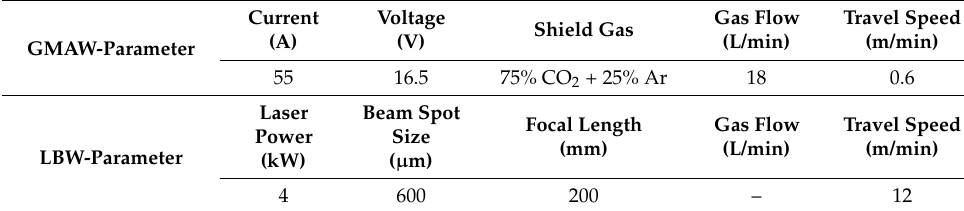
Table 2. Selected welding parameters for GMAW and LBW.